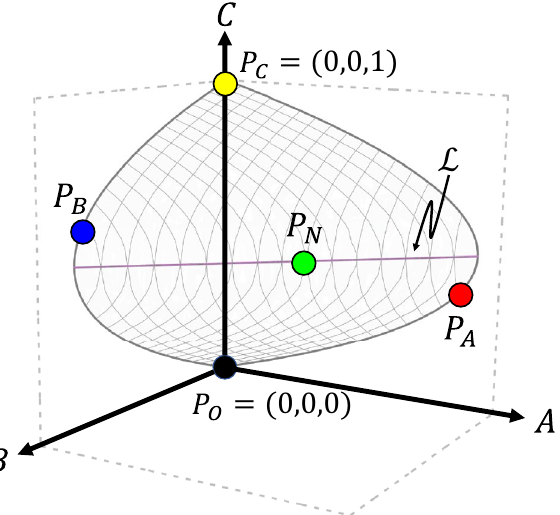
Figure 2. A - B - C space showing the locations of the equilibrium points. P O (black) is an unstable equilibrium at the origin where all species go extinct. P C (yellow) is where only C survives. P A (red) and P B (blue) represent the persistence of one predator ( A and B , respectively) and the prey. These points each lie on a parabola in the B = 0 and A = 0 planes, respectively. P N (green) is a point where all three species coexist, which lies on a line L (purple) that is a line attractor for (cid:31) = (cid:31) ∗ . All five possible equilibria are on the surface a 0 A + b 0 B = C ( 1 − C ) , shown in